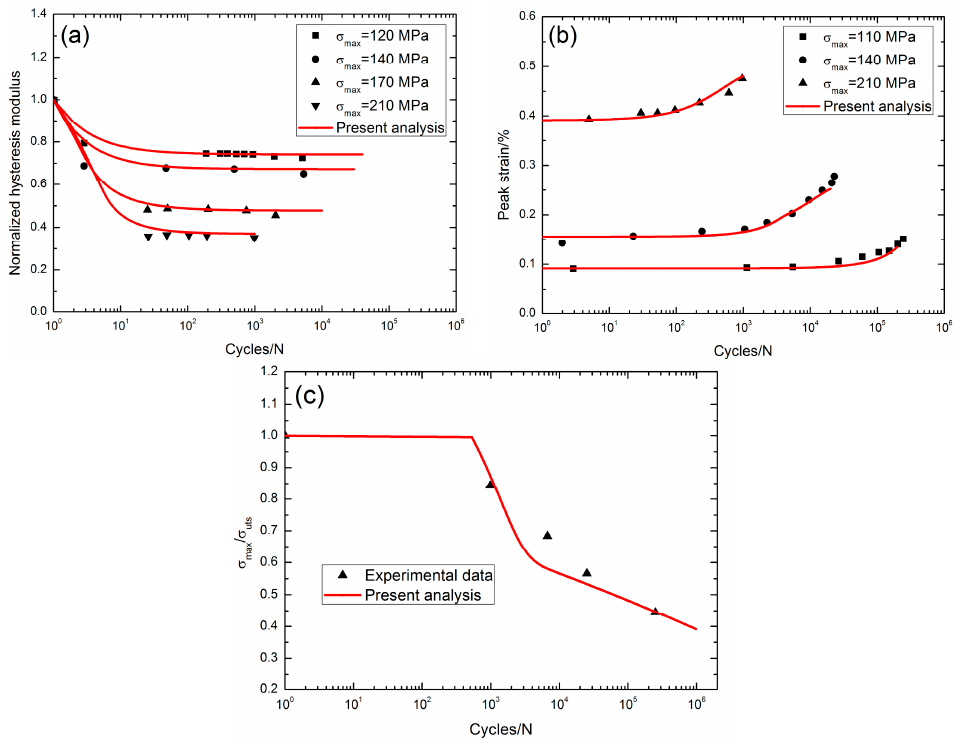
Figure 5. ( a ) The normalized fatigue hysteresis modulus versus applied cycles; ( b ) the peak strain versus applied cycles; and ( c ) the fatigue life S-N curves of 2D SiC/SiC composite at 1100 °C in air [4].